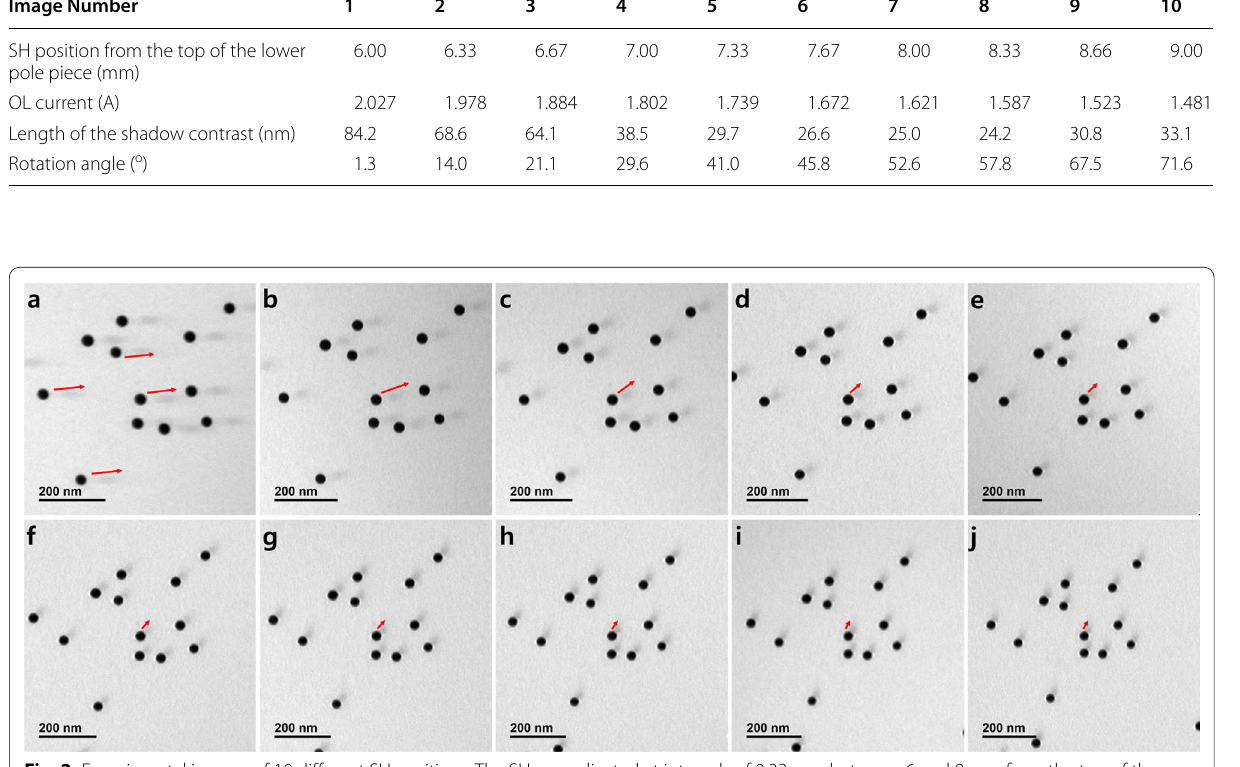
Fig. 2 Experimental images of 10 different SH positions. The SH was adjusted at intervals of 0.33 mm between 6 and 9 mm from the top of the lower P/P. Each image from ( a ) to ( j ) was focused with an appropriate OL current for 10 SH positions. The red arrows indicate the direction of the shadow contrasts formed from